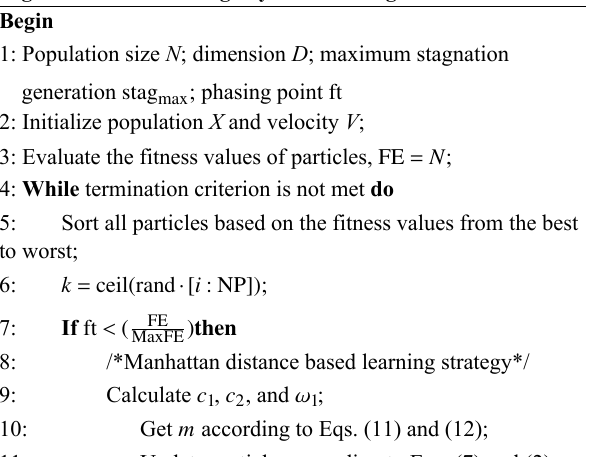
Algorithm 1 Dual-stage hybrid learning